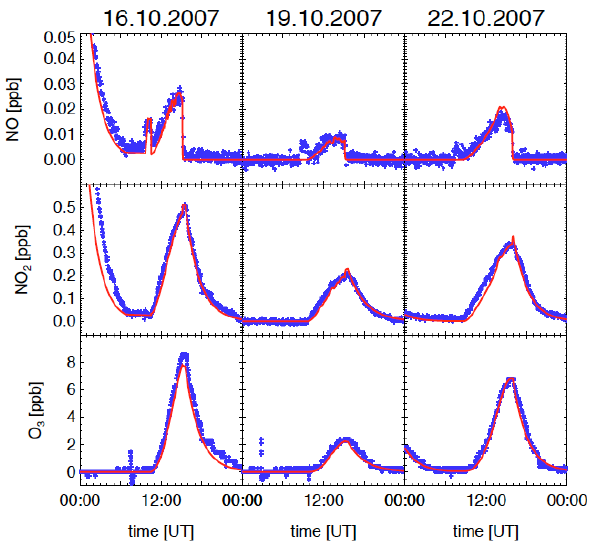
Fig. 3. Comparison of model and measurement results for the pho- Figure 3: Comparison of model and measurement results for the photochemically tochemically important species NO, NO 2 and O 3 . important species NO, NO 2 and O 3 .